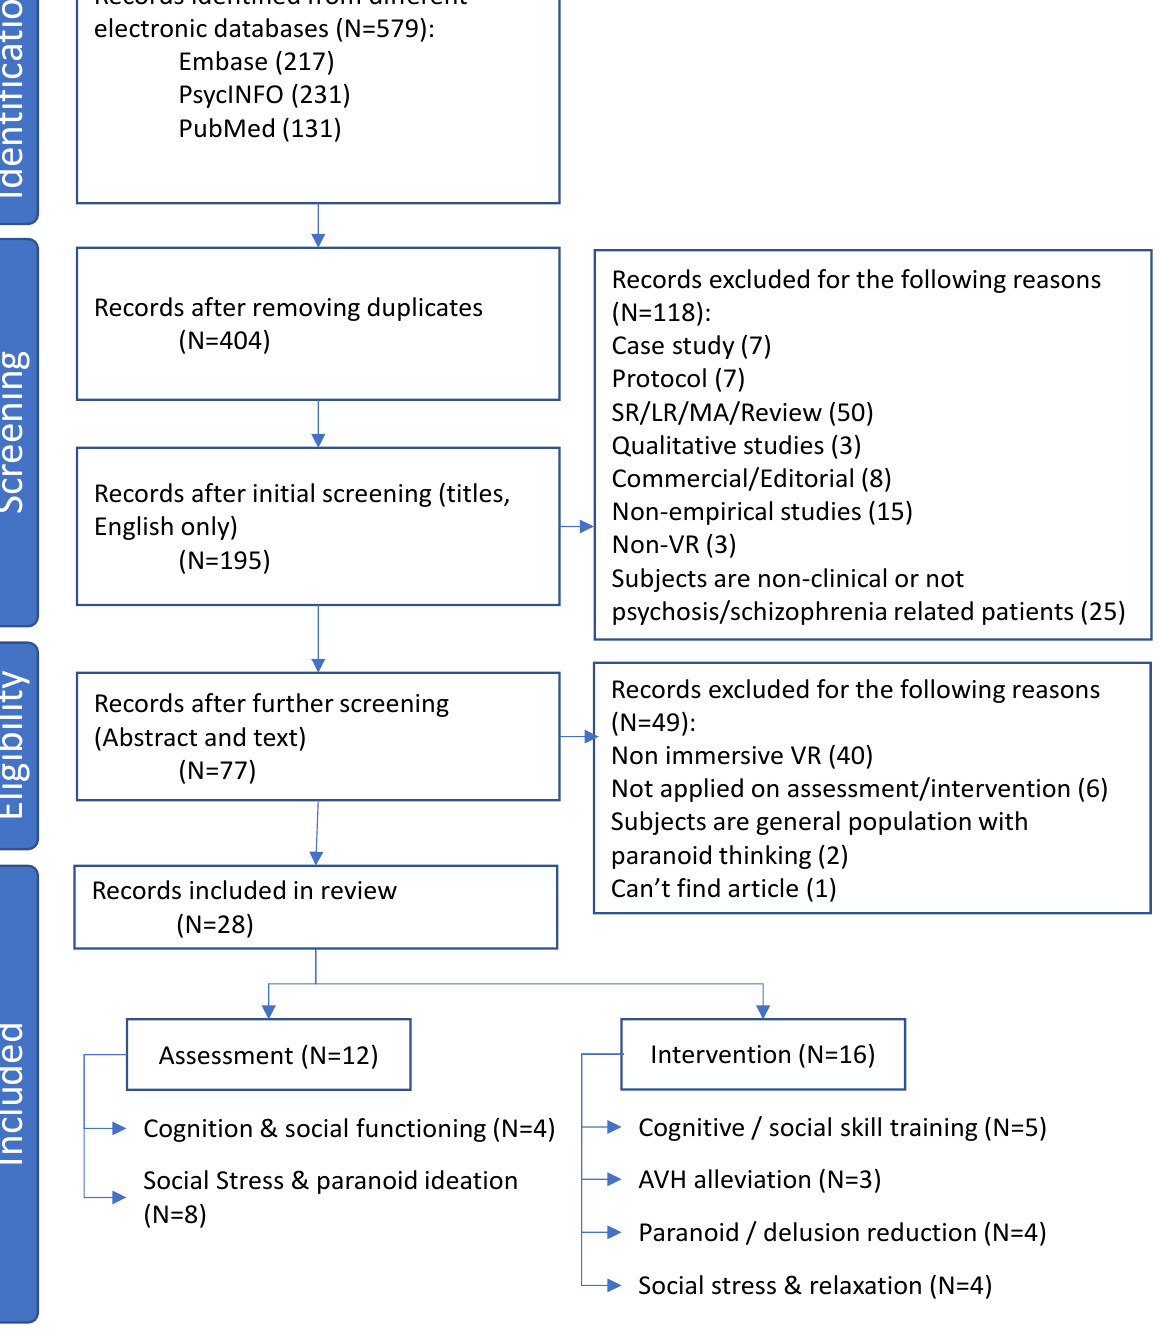
Figure 1. PRISMA (Preferred Reporting Items for Systematic Reviews and Meta-Analyses) flow diagram. Abbreviations: AVH, auditory voice hallucination; LR, literature review; MA, meta-analysis; SR, systematic review; VR, virtual reality.